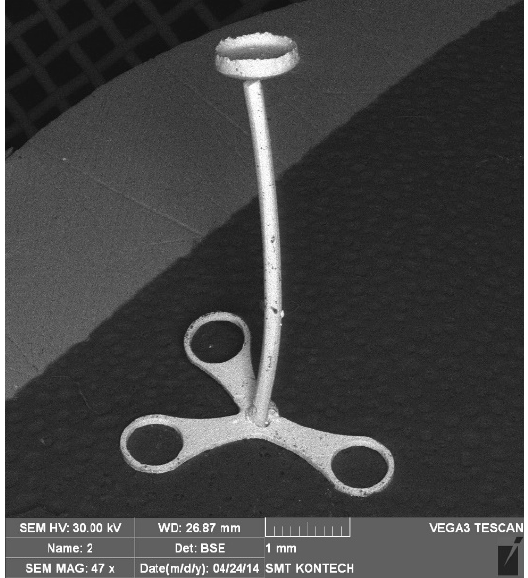
Figure 7. Experimentally made ossicle implant.